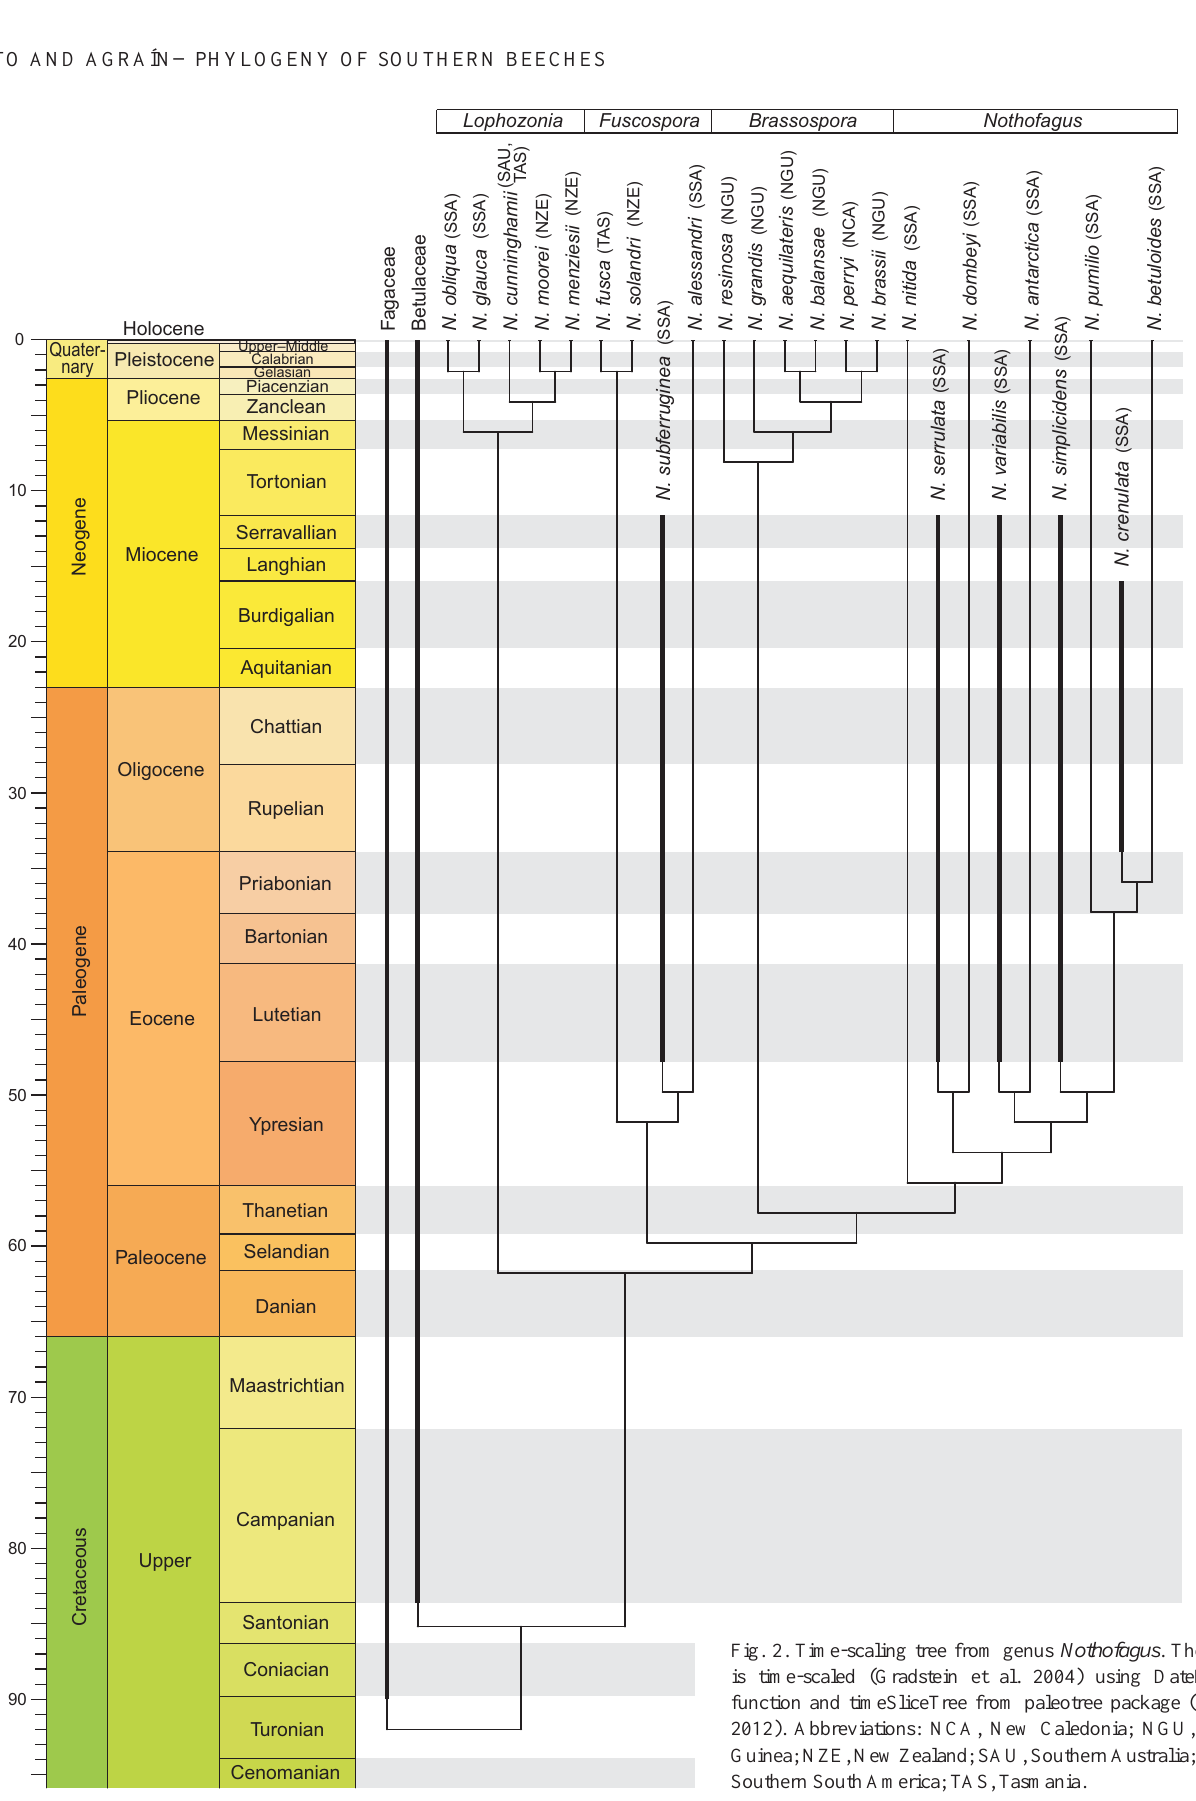
Fig. 2. Time-scaling tree from genus Nothofagus . The tree is time-scaled (Gradstein et al. 2004) using DatePhylo function and timeSliceTree from paleotree package (Bapst 2012). Abbreviations: NCA, New Caledonia; NGU, New Guinea; NZE, New Zealand; SAU, Southern Australia; SSA, Southern South America; TAS,